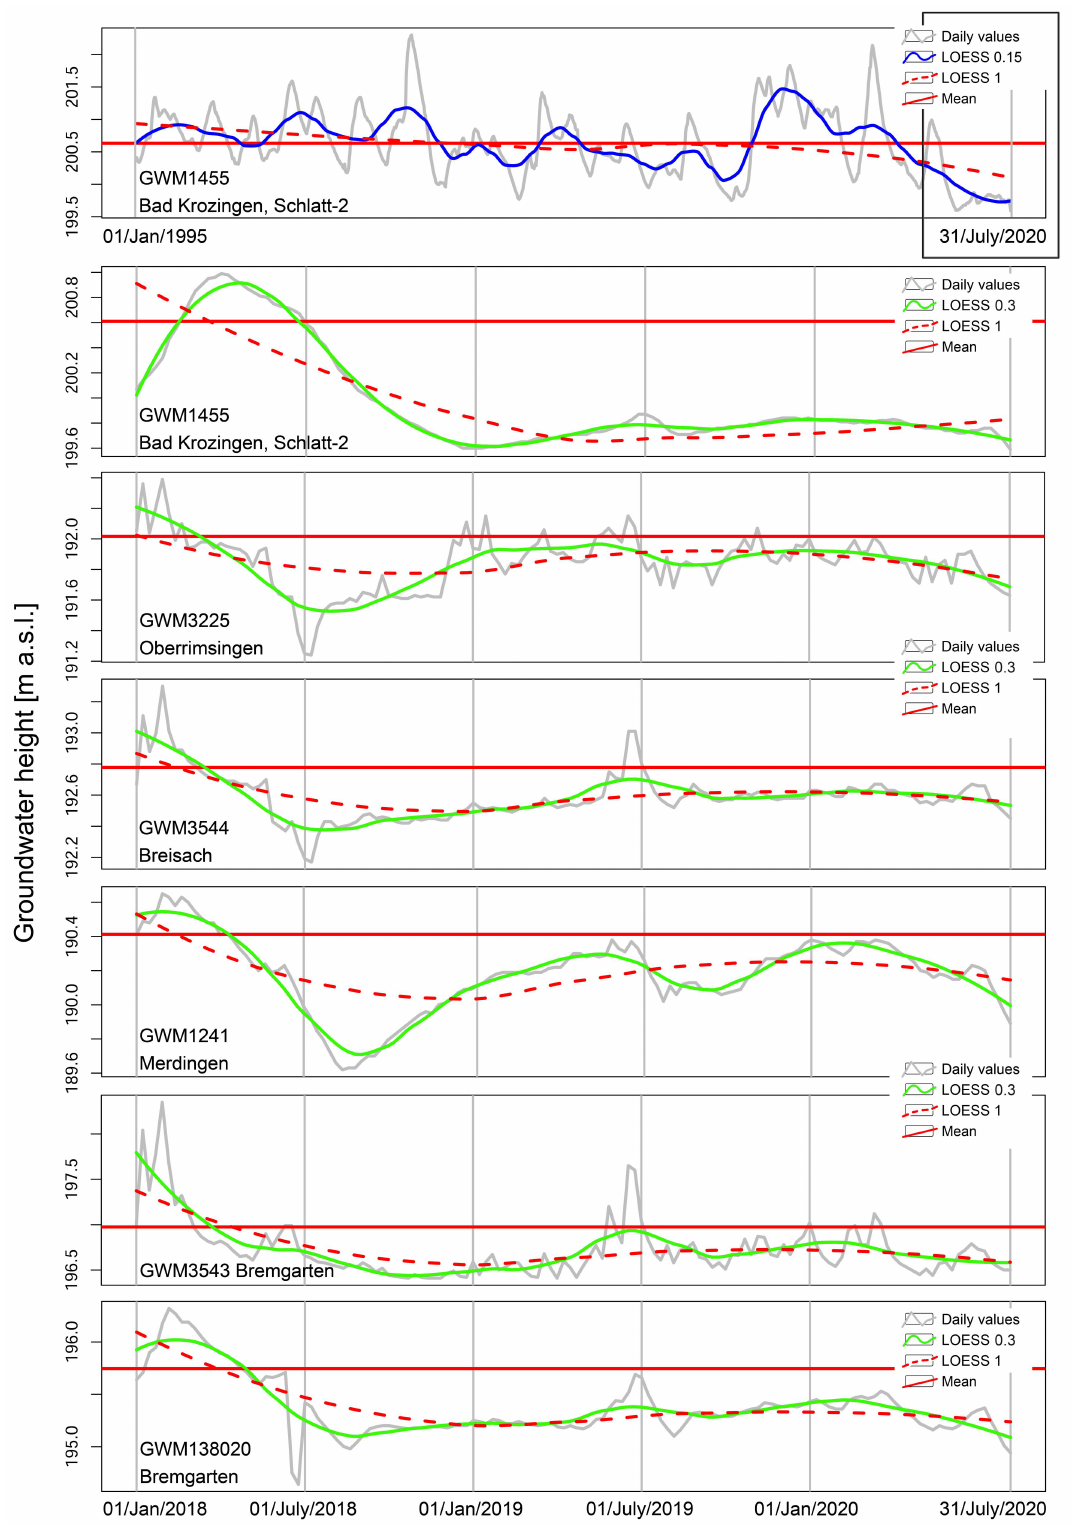
Figure 10. Groundwater level changes at six stations in Baden-Württemberg. Weekly groundwater data was plotted from 1 January 1995–31 July 2020 and for the period 1 January 2018–31 July 2020. The data was smoothed using a local regression smoothing operation with parameters 0.15, 0.3, and 1. All groundwater stations in Baden-Württemberg show severely declining values during July 2020 (data processed from LUBW 2020, last accessed 4 August 2020; additional data provided by Karin Burk and Michel Wingering (LUBW, Ref. 42,